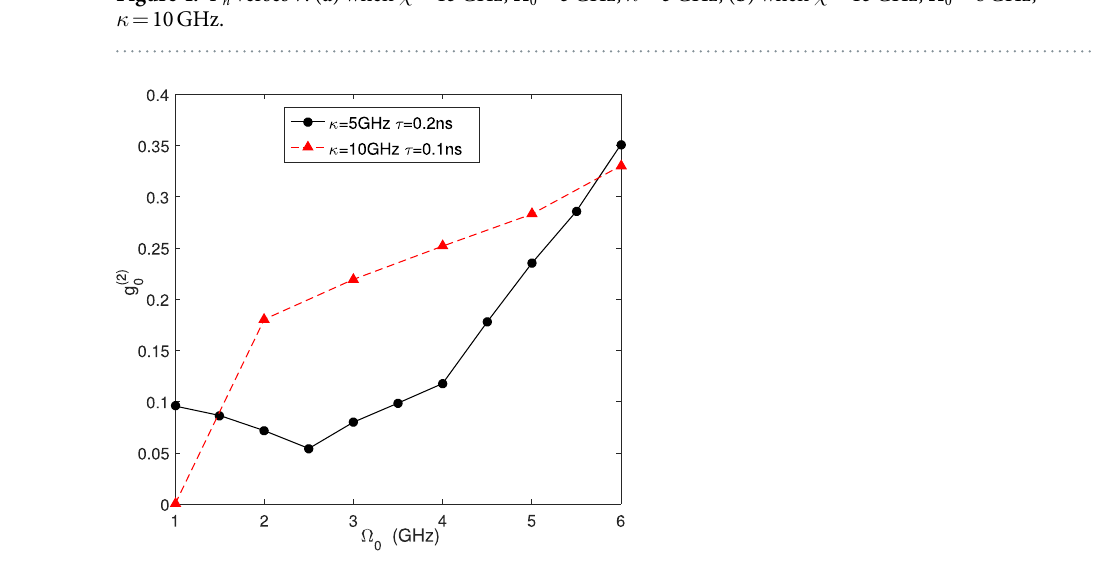
Figure 5. Second correlation function g (2) (0) verses Ω 0 when χ = 15 GHz, τ = 0.2 ns, κ = 5 GHz and χ = 15 GHz, τ = 0.1 ns, κ = 10